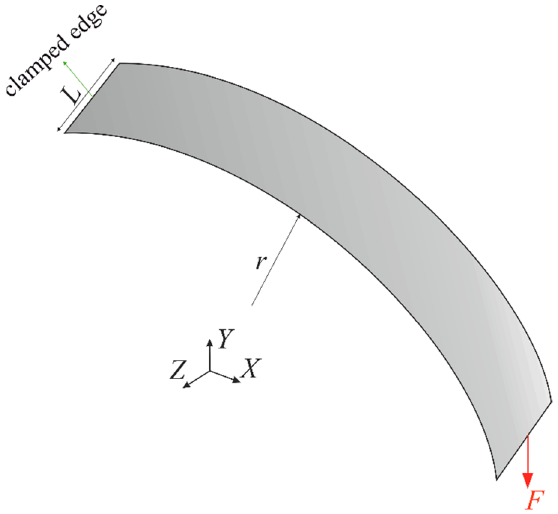
Figure 27. Geometry of the thin-walled cylinder under a concentrated force.